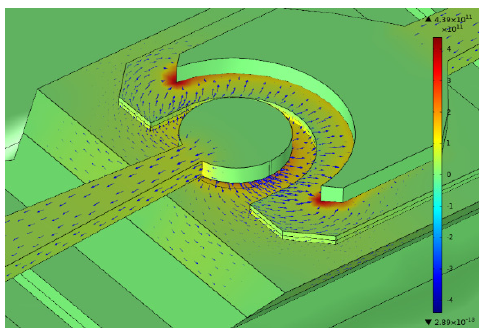
Figure 10. The current density distribution of the diode anode.